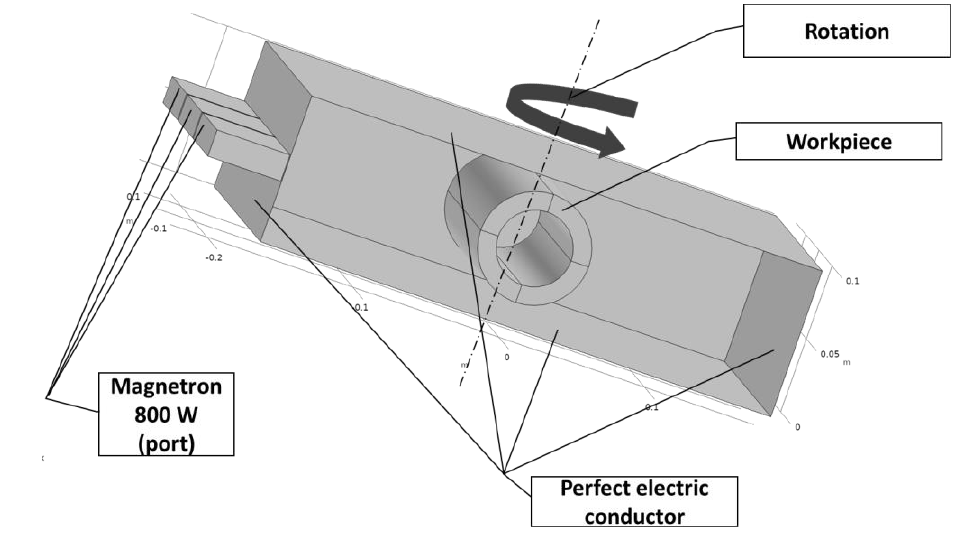
Fig. 1. A geometric model for the positioning of PMC workpiece in the operating area of a microwave heating equipment